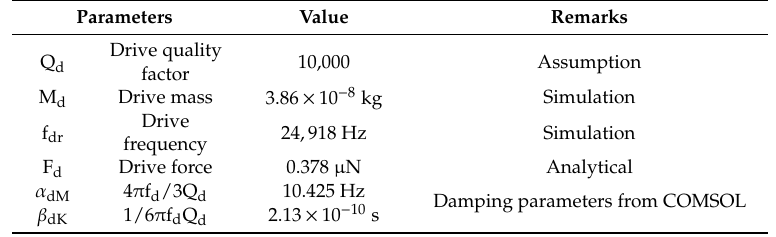
Table 2. Drive-mode analysis parameters for the proposed single-drive, 3-axis MEMS gyroscope. Parameters